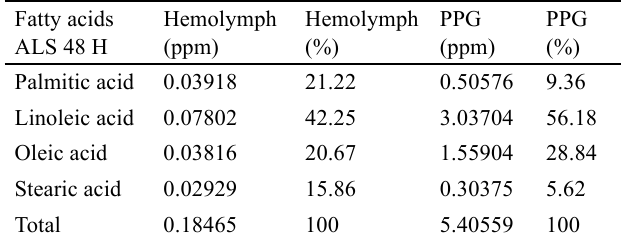
Table 2 . Fatty acid quantification in the hemolymph and postpharyngeal glands (PPG) of Atta sexdens rubropilosa workers after lipid supplementation for 48 h (ALS 48 h).